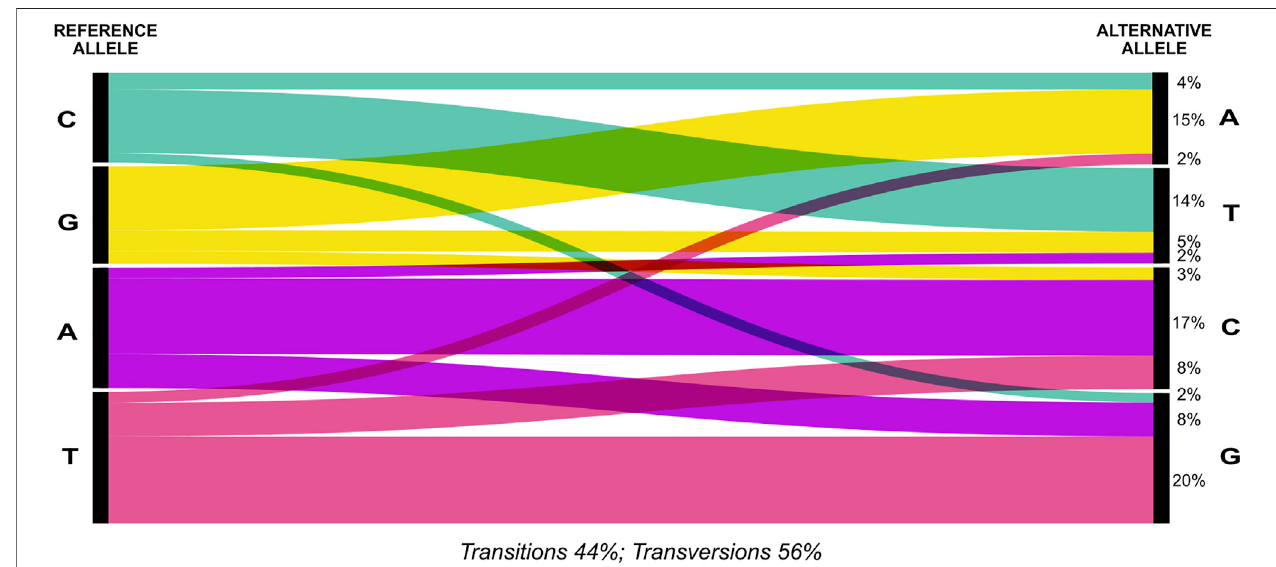
FIGURE 2 | Distribution of transitions and transversions in the SNPs dataset. Percentages (%) of transitions and transversions of the whole set of 7,562 SNPs identi fi ed for 63 individuals is depicted using an alluvial diagram.